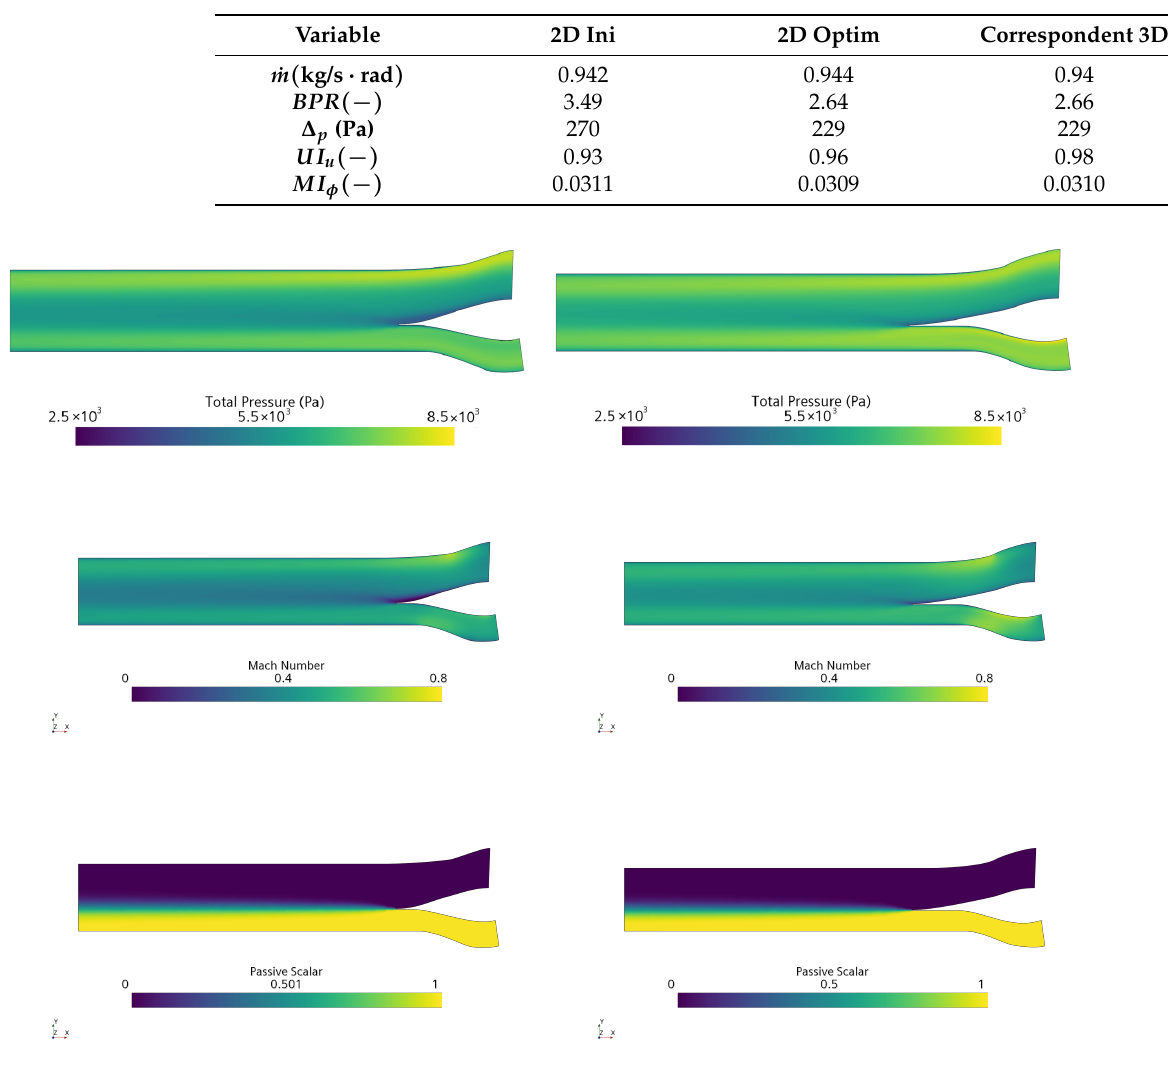
Figure 11. Flow field comparison between the initial ( left ) and the optimum ( right )